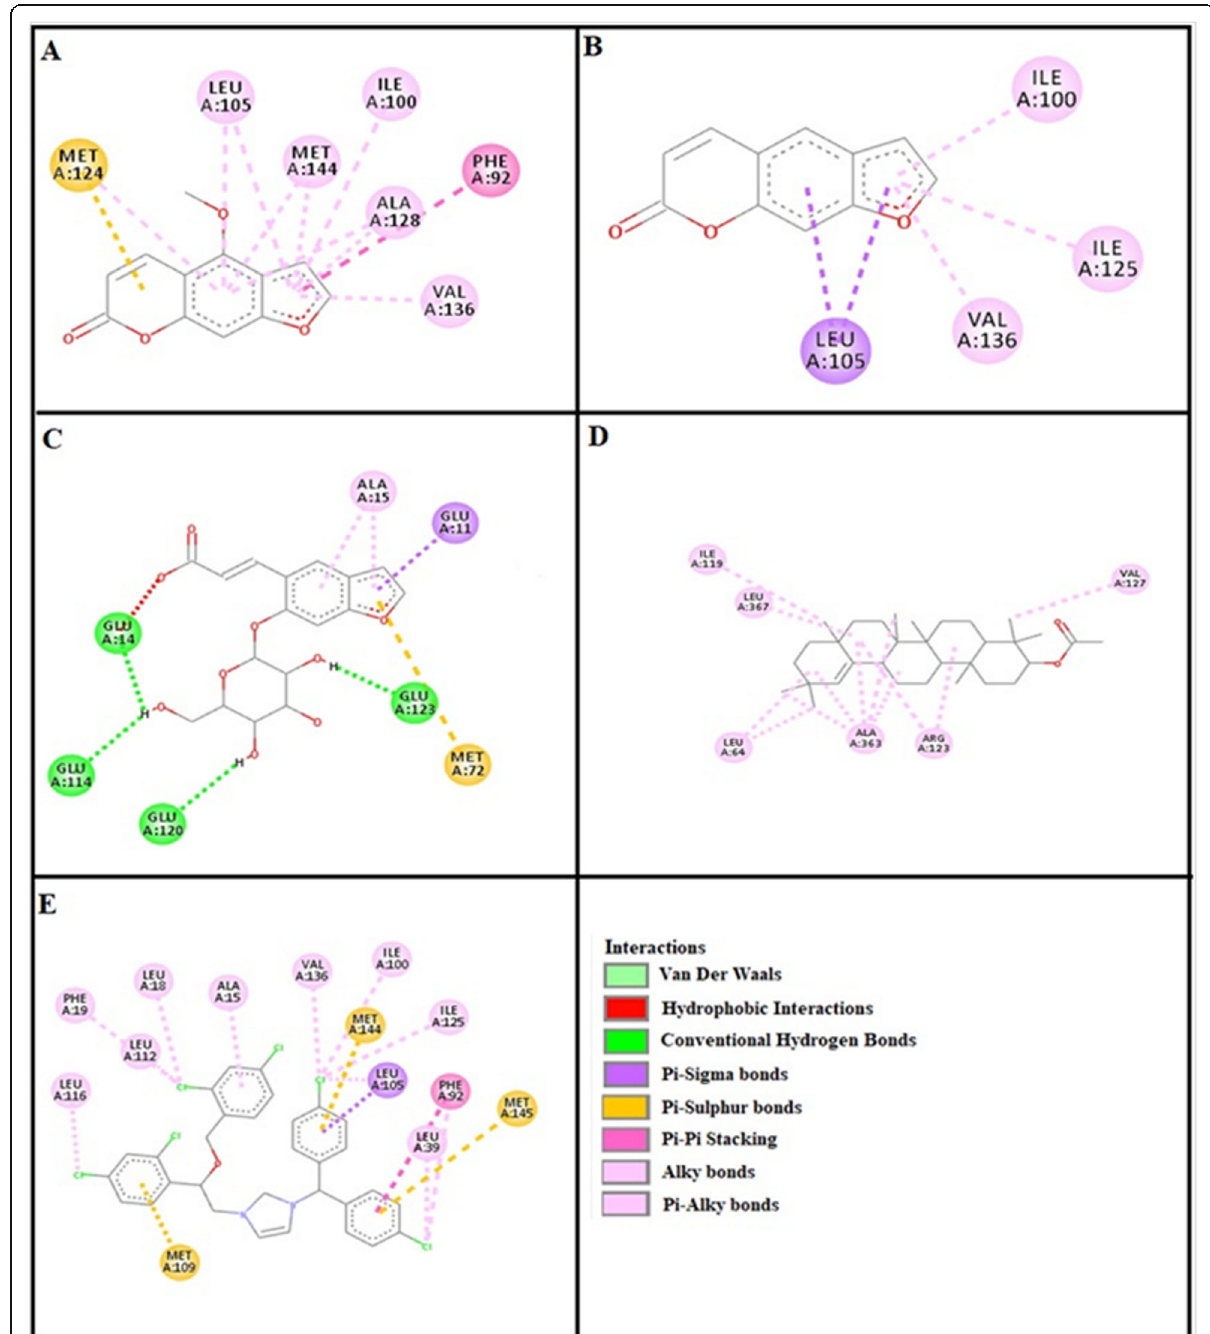
Fig. 9 a , b , c , d and ( e ) represents interactions of bergapten, psoralene, psoralenoside, germanicol acetate and domperidone against target: dopaminergic D 2 receptor respectively, evaluated through Biovia Discovery Studio